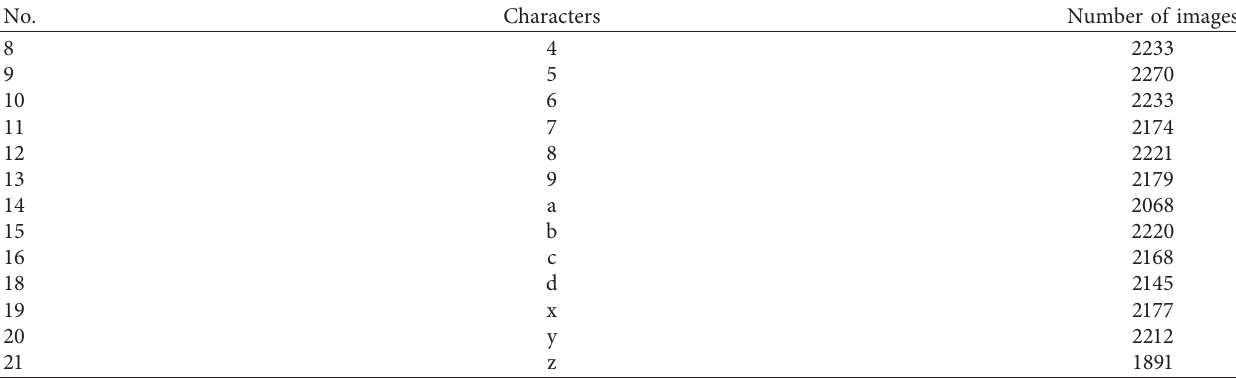
connected as shown in Figure 15 with image input of 28 × 28